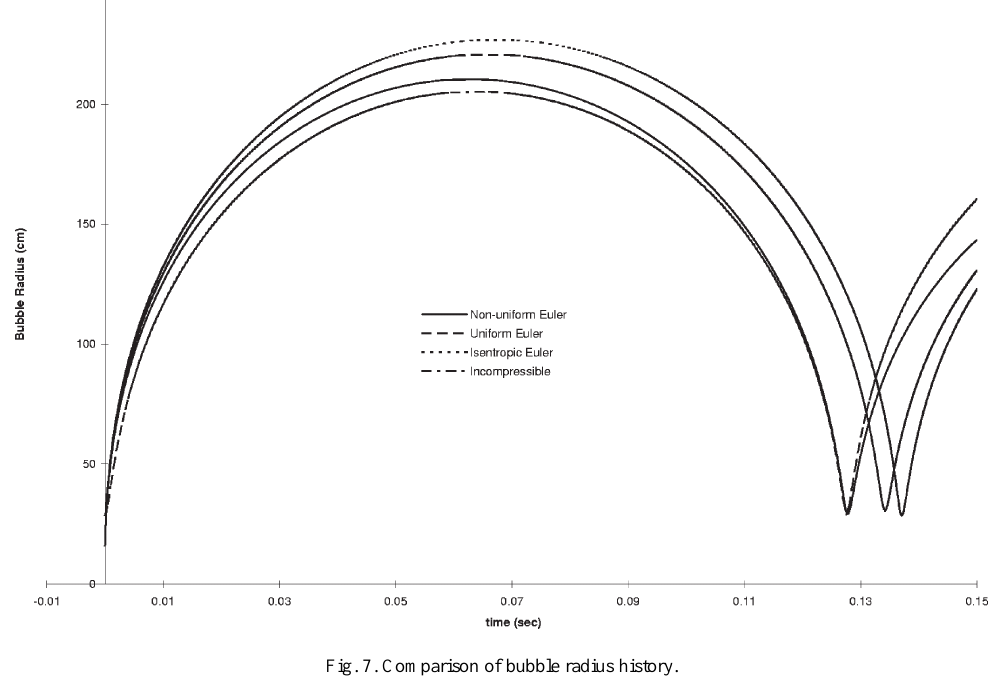
Fig. 7. Comparison of bubble radius history.